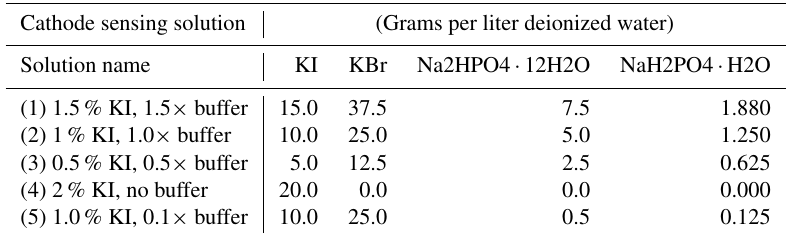
Table 2. Amount of each chemical in grams/liter deionized water used in the five commonly used cathode sensing solutions. (1) Komhyr and Harris (1971), (2) 1994 EN-SCI Model 1Z Instruction Manual, (3) 1996 revised EN-SCI Model 1Z & 2Z Instruction manual, (4) Johnson et al. (2002), (5) currently used by NOAA since